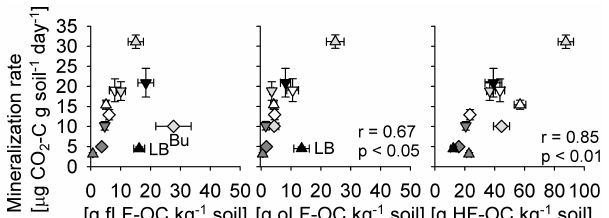
Fig. 10. Soil respiration per gram soil in relation to fLF-OC, oLF- OC and HF-OC per dry weight soil at 0–5cm depth (LB: Le Bray, Bu: Bugac, fLF free light fraction, oLF occluded light fraction, HF heavy fraction, black: coniferous forest, dark grey: croplands, light gray: grasslands, white: deciduous